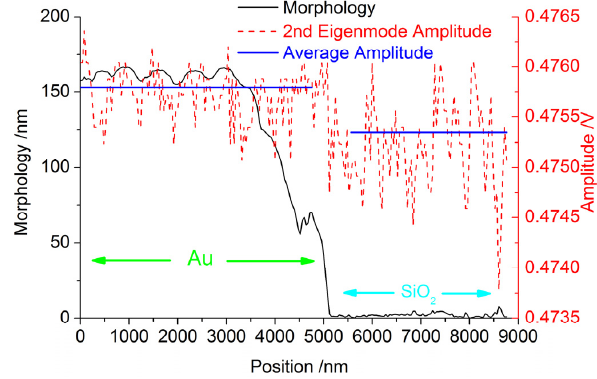
Figure 16. The profile of the sample. Table 6. The results of tests on the Micro-Electro-Mechanical System (MEMS) sample at intervals of 1 μ m.